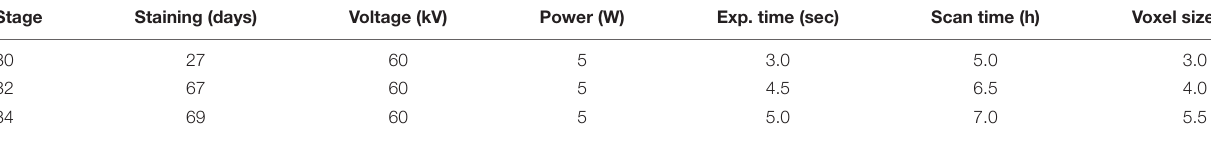
TABLE 2 | Chimaeroid dorsal pelvic musculature and their points of origin (O) and insertion (I). Muscle